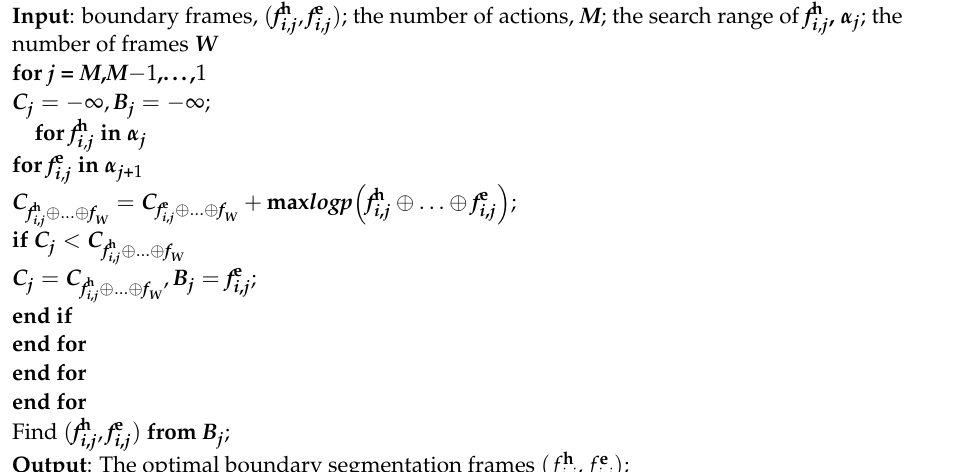
Algorithm 1: Dynamic Programming for Optimal Boundary Segmentation